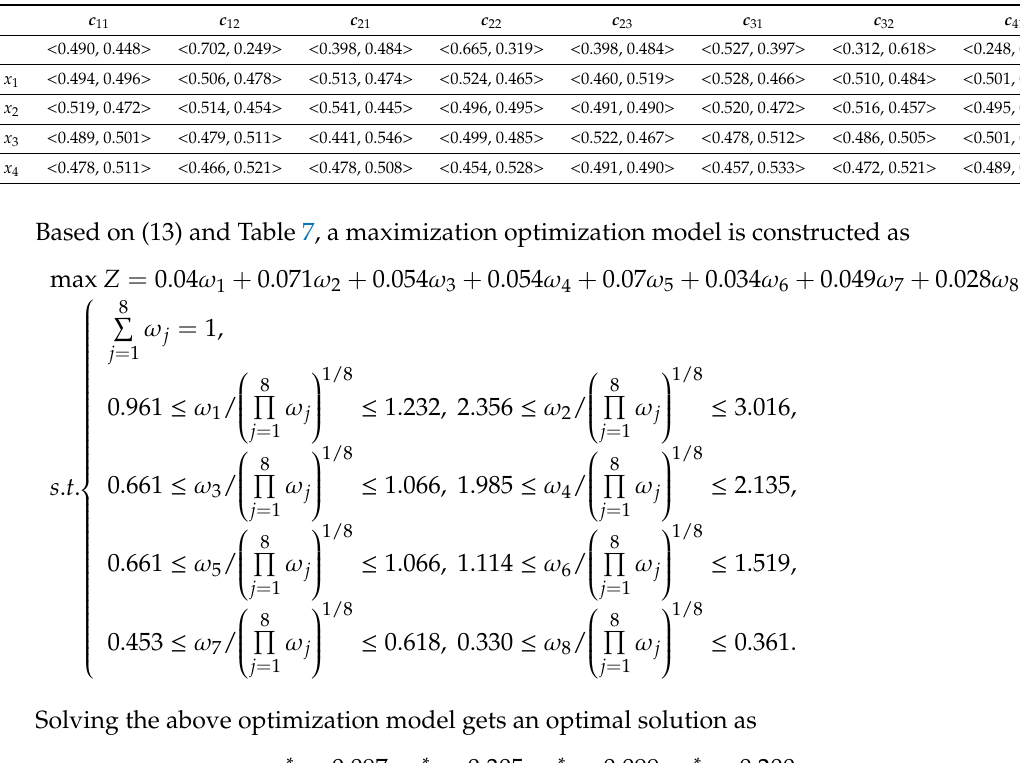
Table 7. Multiplicatively normalized intuitionistic fuzzy decision